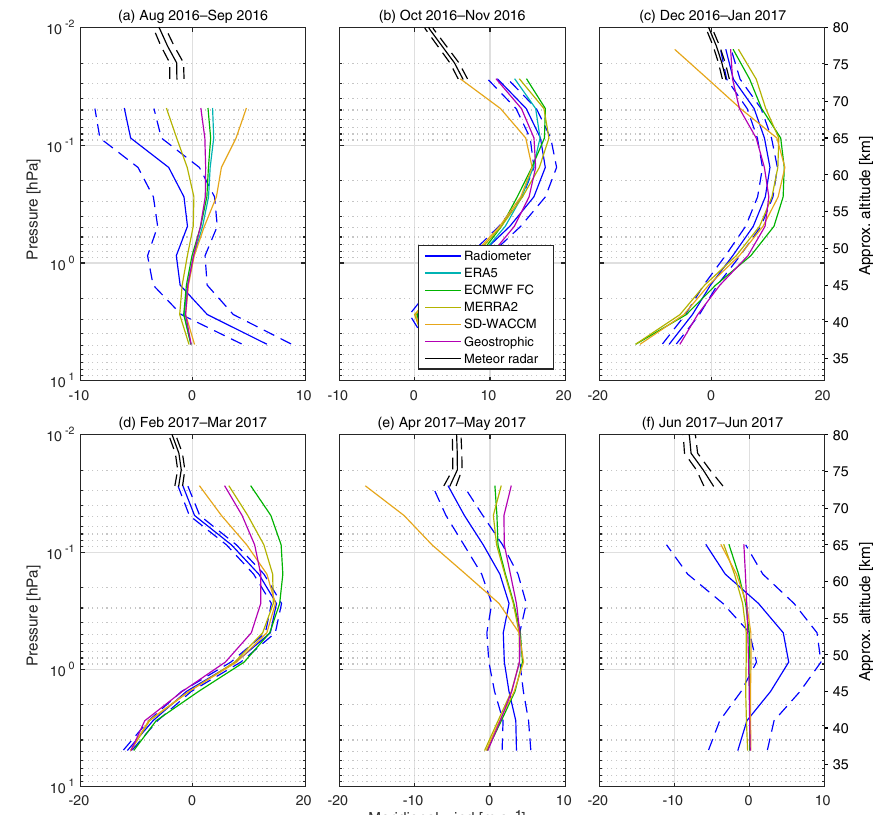
Figure 12. As Fig. 11 but for the meridional wind